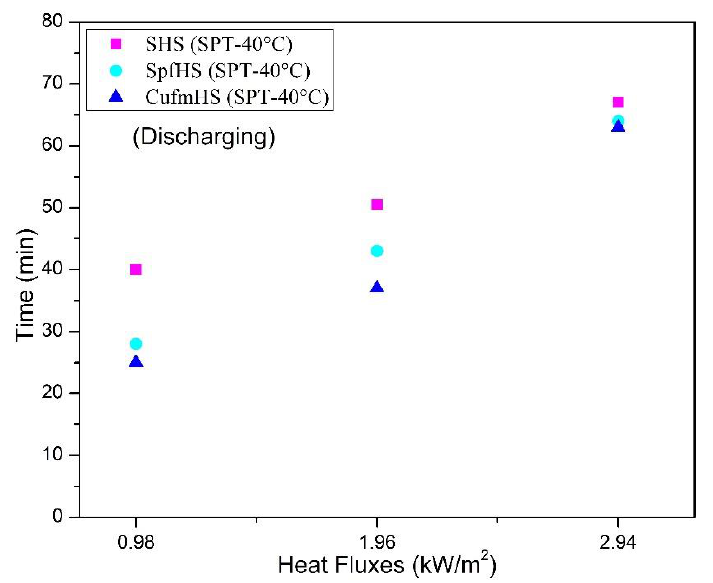
Figure 10. Operational time SPT (40 °C) comparison of various heat sinks against various heat fluxes.